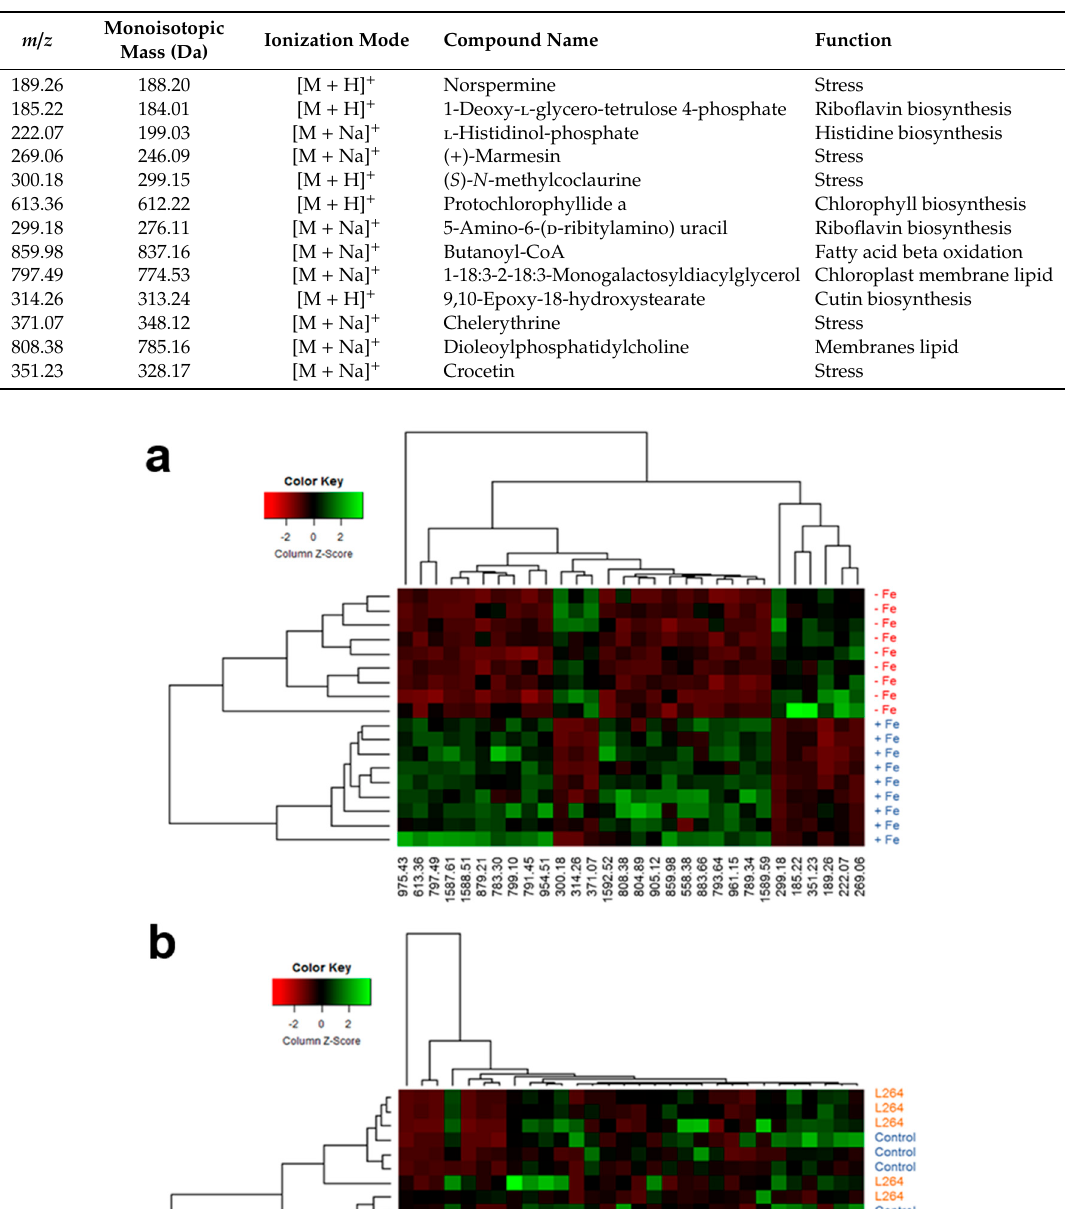
Table 1. The most important compounds detected in Medicago truncatula seedlings by DLI-ESI-MS and putatively identified by the SpiderMass software, which were able to di ff erentiate between samples grown under Fe-su ffi cient and -deficient growth conditions.